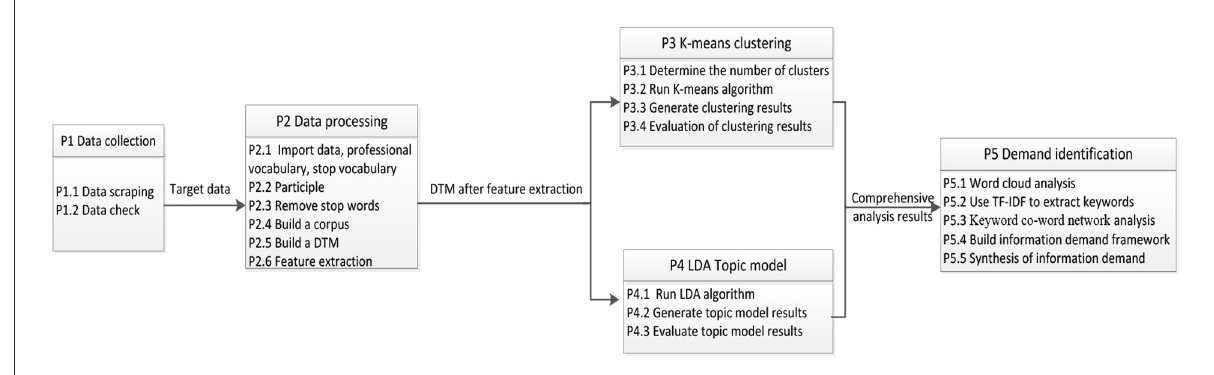
FIGURE1 Procedure for analyzing the public COVID-19 vaccine information